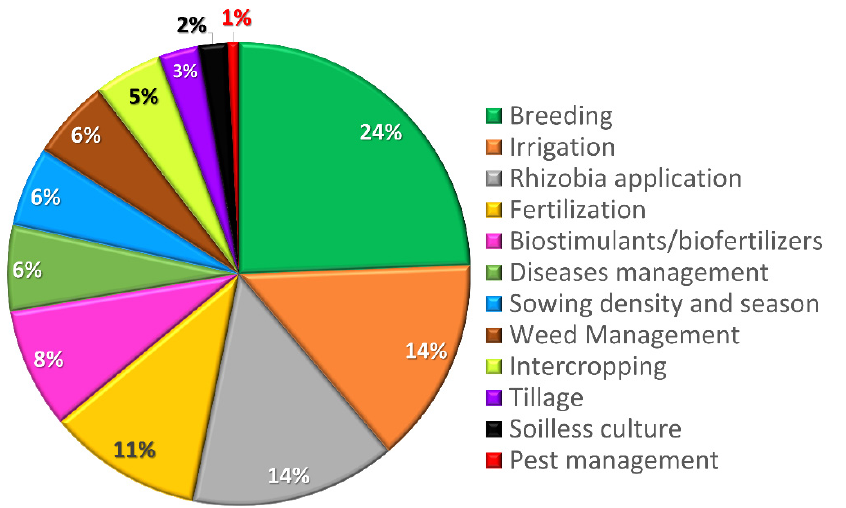
Figure 2. The percentage (%) of the studies of the twelve main agronomic practices that were identified during the screening and included in the systematic review.